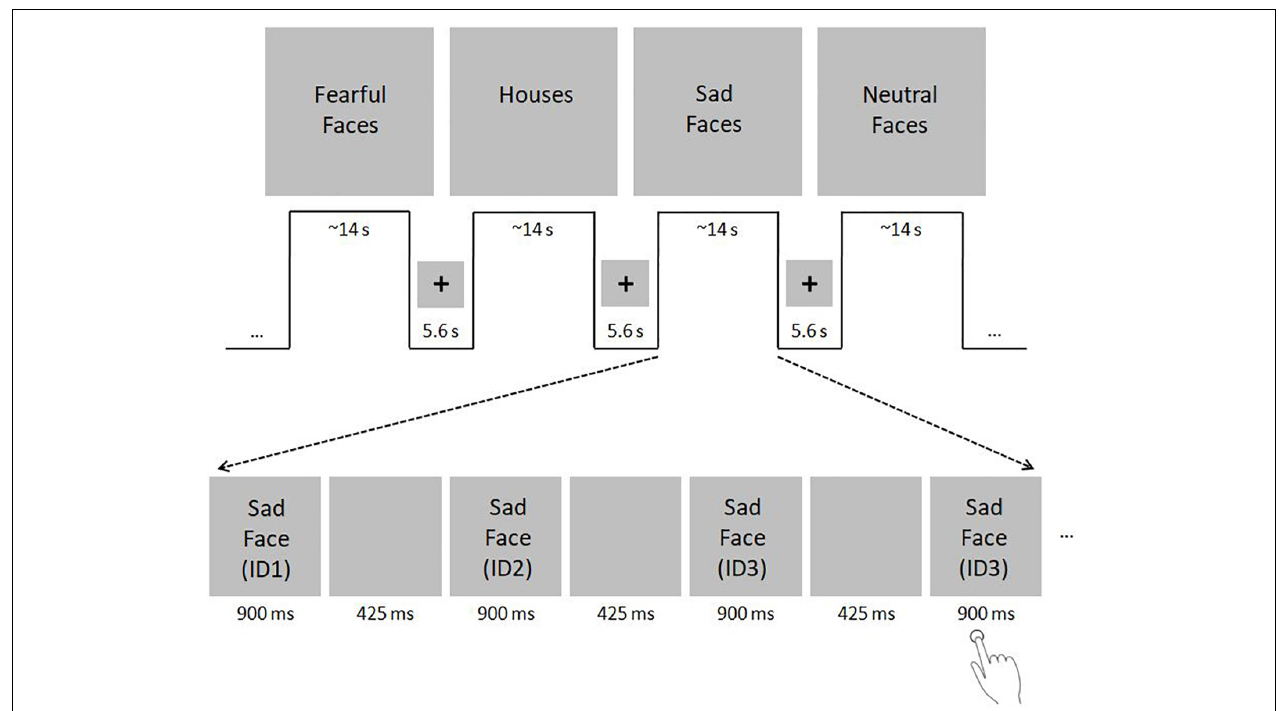
FIGURE 1 | fMRI paradigm. Subjects viewed either gray-scale faces with neutral, sad or fearful faces in the activation condition and houses in the control condition in a blocked design. Face stimuli were selected from the Karolinska Directed Emotional Faces (KDEF) dataset (http://www.emotionlab.se/resources/kdef; permission for publication of KDEF stimuli was kindly provided by the Karolinska Institutet, Department of Neuroscience, Section of Psychology, Stockholm, Sweden; Lundqvist et al., 1998). House stimuli were selected from the internet. To ensure equalized size of face and house images, stimuli were resized to 500 × 400 pixel using ImageMagick for Linux. For purpose of color and luminance matching, stimuli were transferred into gray-scale images and adjusted for mean luminance using the SHINE toolbox for MATLAB (Willenbockel et al., 2010). The paradigm consisted of two sessions, including 16 blocks each (4 blocks with neutral, sad and fearful faces, respectively; 4 house blocks). The sessions were divided by a short break of 20 s. Each block included 11 stimuli that were presented for 900 ms with an inter-stimulus interval of 425 ms. Blocks lasted ∼ 14 s each and were separated with blank periods (duration: 5.6 s) in which only a centered fixation cross was shown. The order of blocks remained the same across all subjects, whereas the order of images in each block was pseudo-randomized. To ensure attention, subjects were asked to indicate via button press with the right index finger when a stimulus was shown twice consecutively. Within one block, either two or three stimulus-pairs arose, which sum up to 40 target events in the whole fMRI paradigm. The total duration of the fMRI paradigm was ∼ 11 min. The fMRI paradigm used in the present study was a slightly modified version of the standard paradigm used in our group (e.g., Frässle et al., 2016b) to adapt for the assessment of children. First, to minimize the total scanning time, the number of blocks was reduced from 44 to 32. Second, the stimulus presentation time was tripled to 900 ms. Third, the number of stimuli per block was reduced from 20 to 11. Fourth, the number of different face identities was reduced from 30 to 20 (10 female and 10 male identities). The number of different houses was also reduced from 30 to 20, to match it with the number of face stimuli.